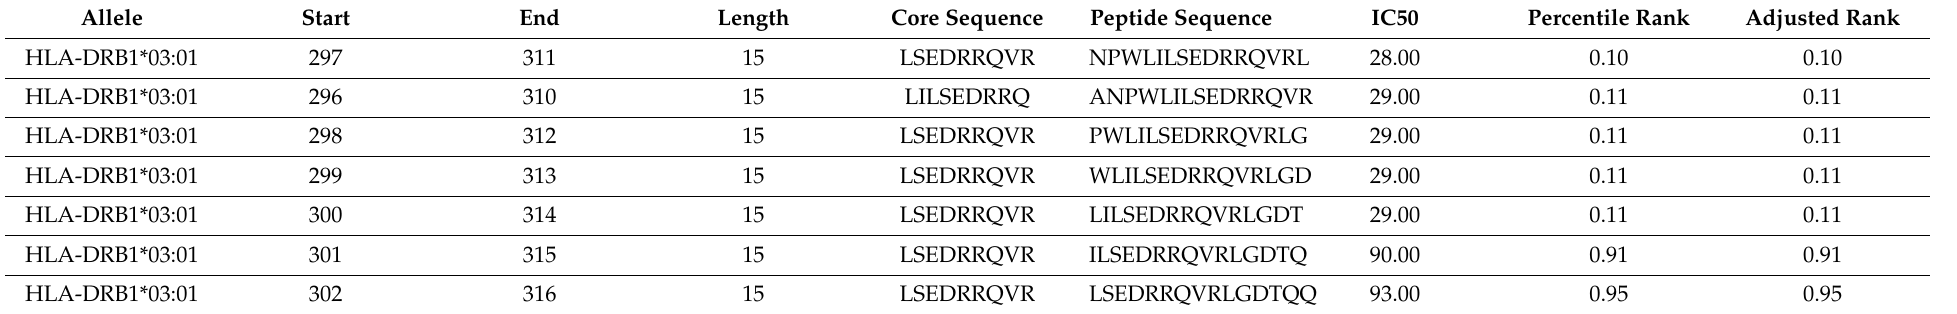
Table 4. HLA-DR3 allele with predicted peptides of human